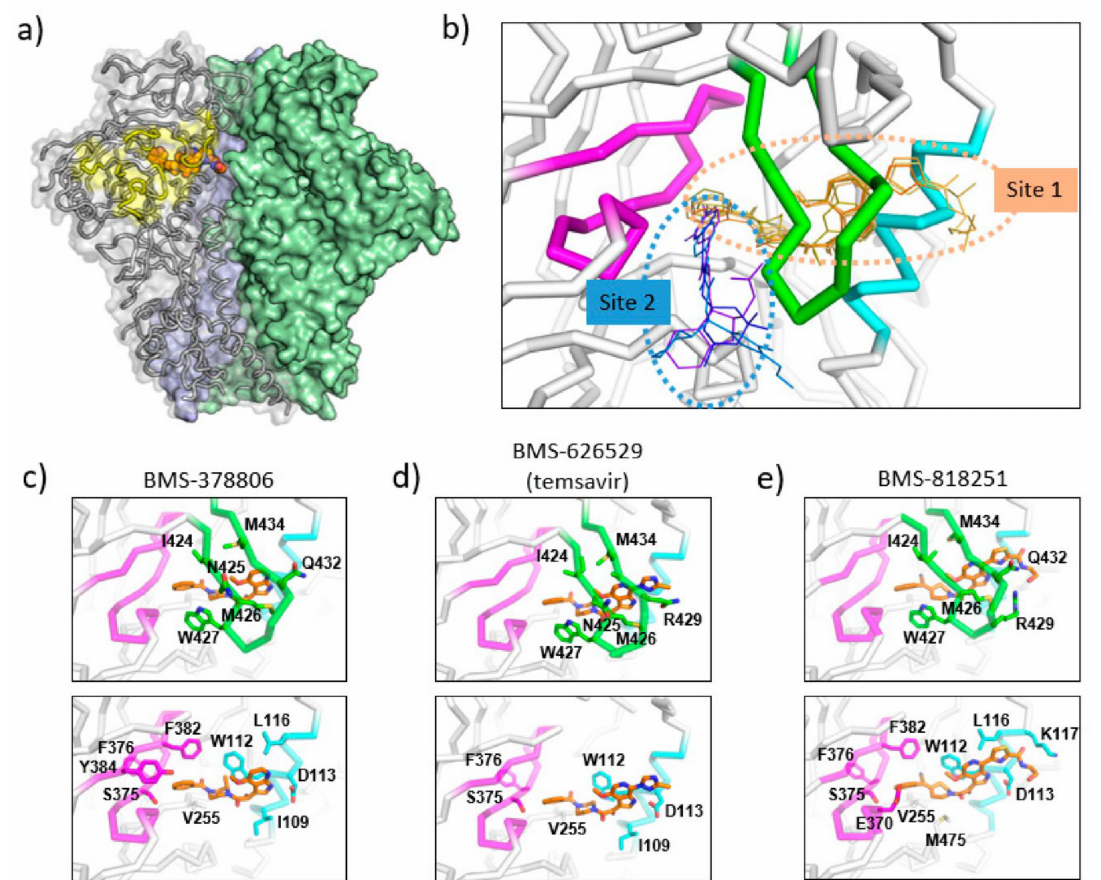
Figure 3. Binding sites of temsavir and related compounds on HIV-1 Env. ( a ) One protomer of the Env trimer is shown as ribbon with transparent surface, while the other two protomers are shown as solid surfaces in green and blue. CD4 binding site is shown as yellow surface patch. A temsavir analog BMS-818251 is represented as orange spheres. ( b ) Two partially overlapping but distinct inhibitor binding sites are present in the vicinity of CD4 binding site. Inhibitors with available complex structures are shown superimposed. Inhibitors binding to site 1 are colored in orange/brown shades and include BMS-626529 (temsavir; PDB: 5U7O), BMS-378806 (PDB:6MTJ), BMS-818251 (PDB:6MU7), BMS-814508 (PDB:6MU6), BMS-386150 (PDB:6MU8) and compound 484 (PDB:6MTN). Inhibitors binding to site 2 are colored in blue/purple shades and include NBD-556 (PDB:3TGS), NBD-10007 (PDB: 4DKV), and DMJ-II-121 (PDB: 4I53). Detailed interactions between HIV-1 Env and BMS-378806, BMS-626529 (temsavir), and BMS-818251 are shown in panels ( c – e ), respectively. b20-b21 hairpin (residues 423–436) is shown as green ribbon. The C-terminus of a1 helix (residues 107–117) is shown as cyan ribbon, and part of CD4-binding loop (residues 369–385) is shown as magenta ribbon. The b20-b21 hairpin is removed in the lower panels of ( c – e ) for clarity. HIV-1 Env residues that interact directly with inhibitors are shown as sticks with residue type and number labeled. Figure 3e was originally published in Nat Commun 10, 47 (2019)